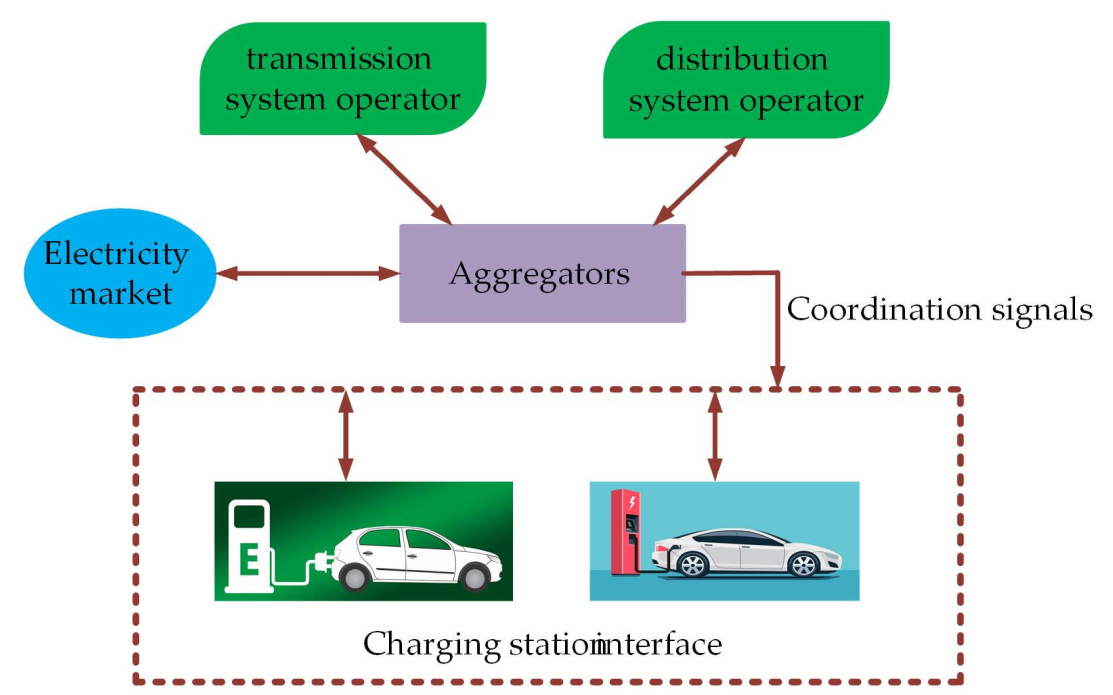
Figure 4. Coordination framework of EVs with